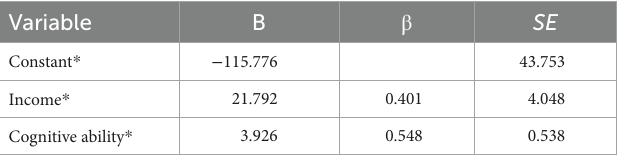
R 2 : 0.703. Table 2 shows the relationship between PISA achievement (dependent variable) and average annual national income and aggregated cognitive ability scores (NIQ) for N = 77 countries and jurisdictions that participated in PISA 2018. * Value of p <